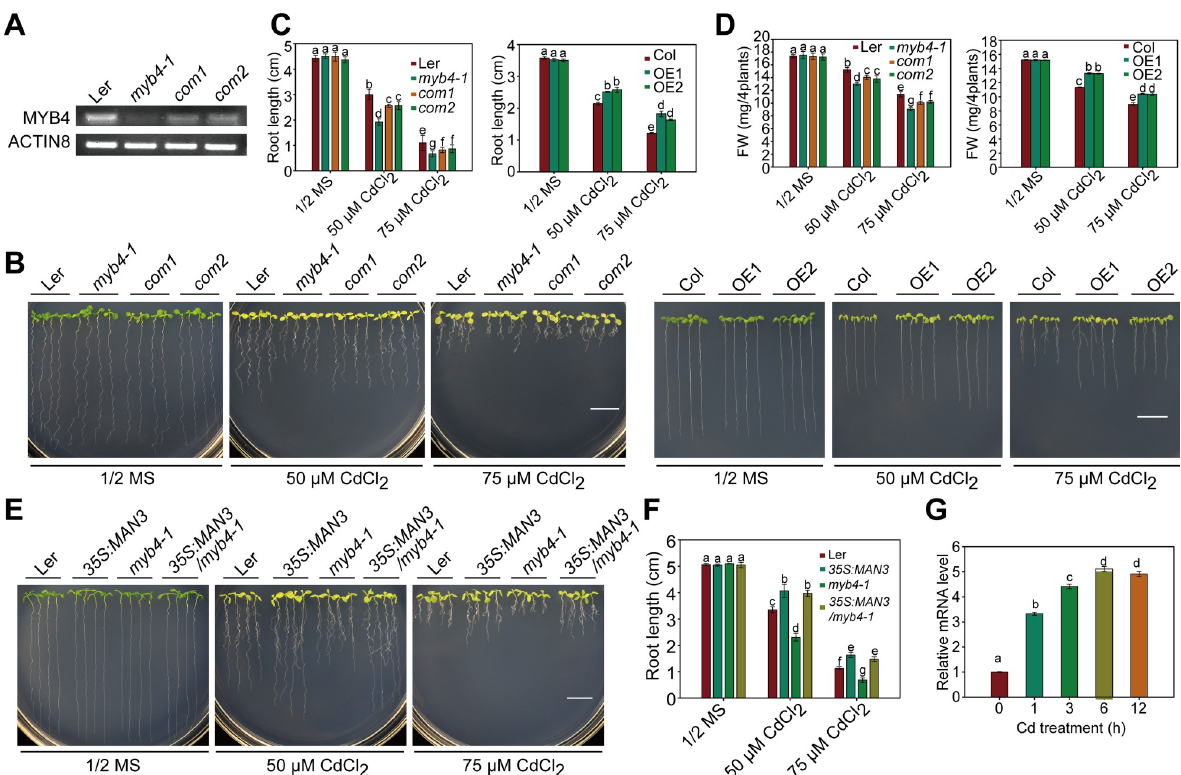
Fig 5. MYB4 regulates Cd tolerance by activating MAN3 . (A) RT-PCR analysis of the transcript level of MYB4 in Ler, myb4-1 and myb4-1- COM lines. ACTIN8 was used as an internal control. (B) Cd tolerance of Ler, myb4-1 , myb4-1- COM, Col, MYB4-OE lines seedlings. (C, D) Root length (C) and fresh weight (D) of plants described in (B). (E) Cd stress phenotypes of the wild-type Ler, myb4-1 , MAN3-OE , myb4-1/ MAN3-OE plants. (F) Root length of plants described in (E). In B and E, three-day-old seedlings grown on 1/2 MS medium were transferred to 1/2 MS medium with or without 50 or 75 μ M CdCl 2 for about 2 weeks. Scale bar = 1 cm. In C, D and F, three independent experiments were done with similar results, each with three biological replicates. Four plants per genotype from one plate were measured for each replicate. Data are presented as means ± SD, n = 3. Bars with different lowercase letters are significantly different at P < 0.05 (Tukey’s test). (G) Induction of MYB4 by Cd stress. Wild-type plants were grown on 1/2 MS mediun for 2 weeks and then treated with 50 μ M CdCl 2 for 0, 1, 3, 6, 12 h before the tissues were harvested for RT-qPCR analysis. GAPDH was used as an internal control. Data are presented as means ± SD of three biological